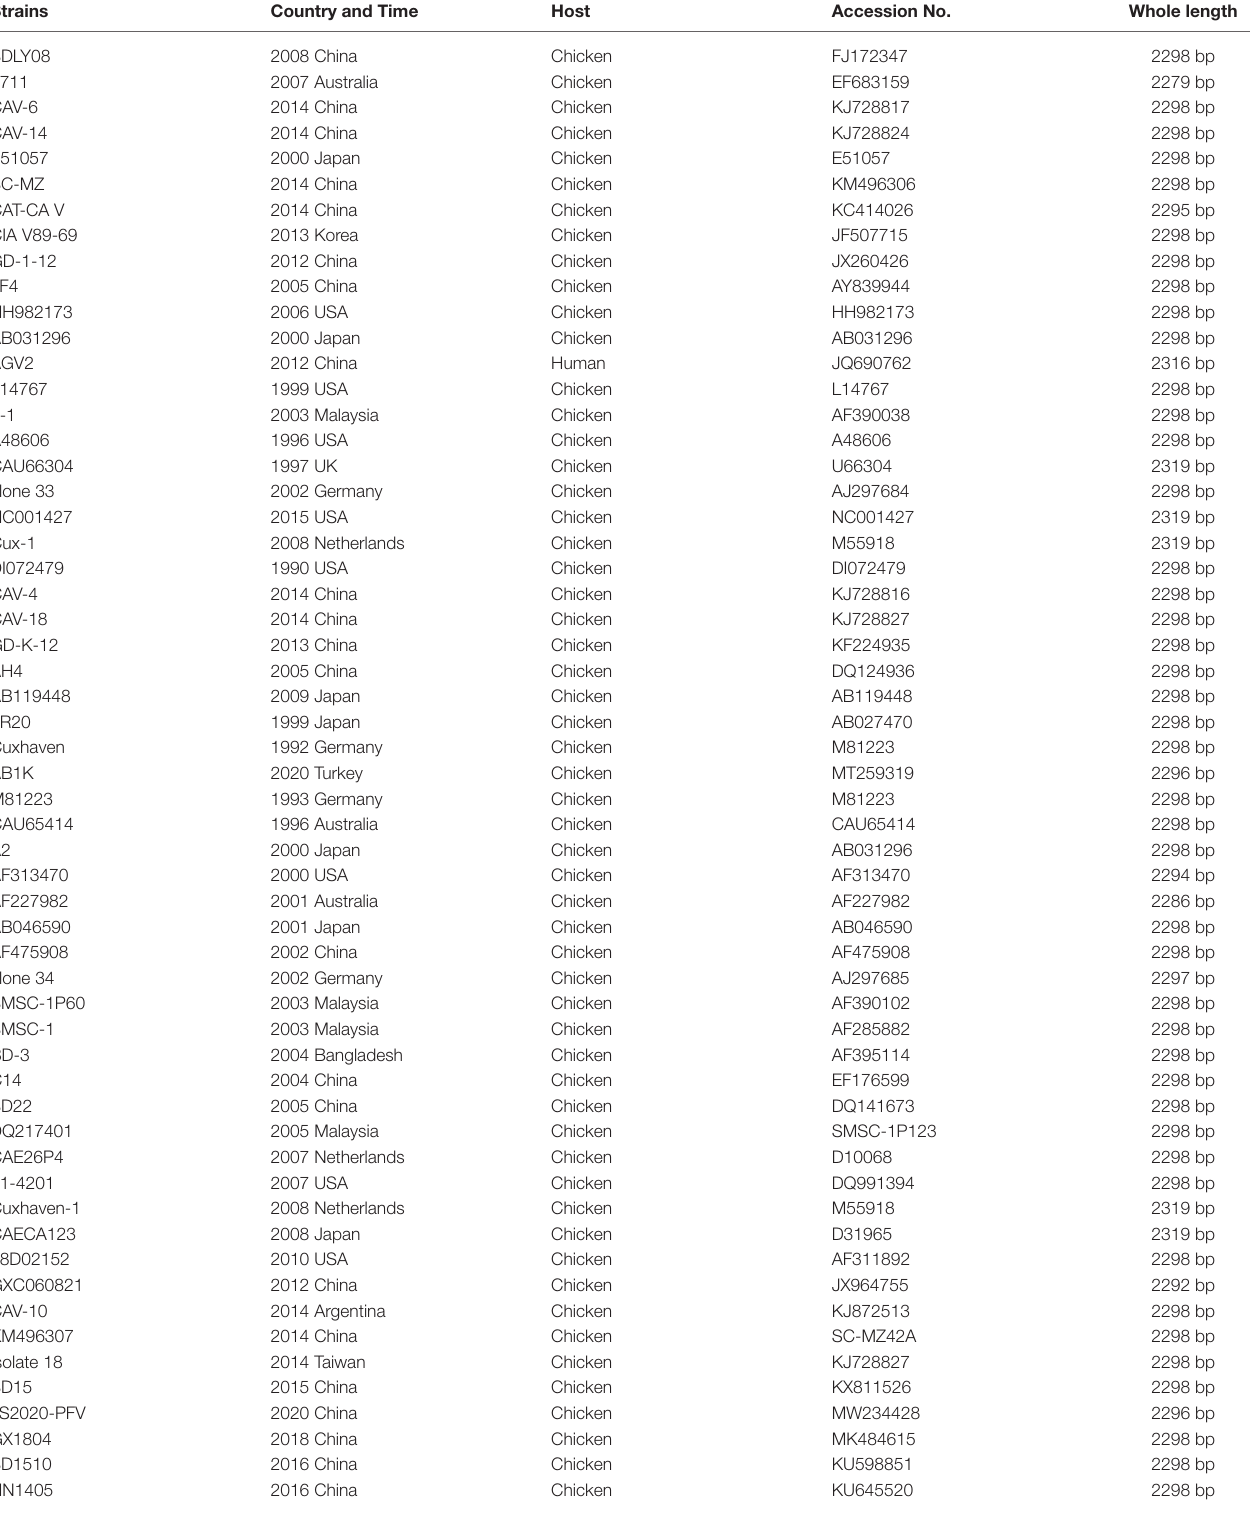
TABLE 2 | CIAV strains were used as reference strains in this study. Strains Country and Time Host Accession